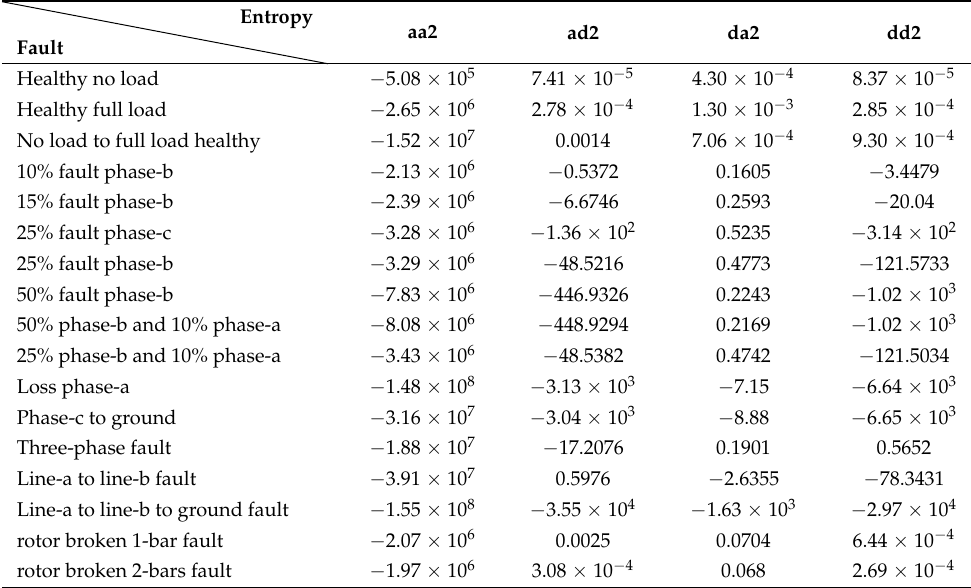
Table 3. Entropy Energy values for different operating conditions of the induction motor at its four WPT second level subbands.